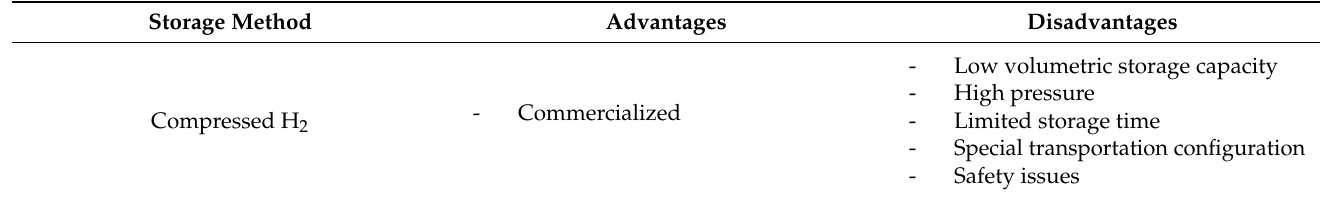
Table 3. Comparison of various hydrogen storage